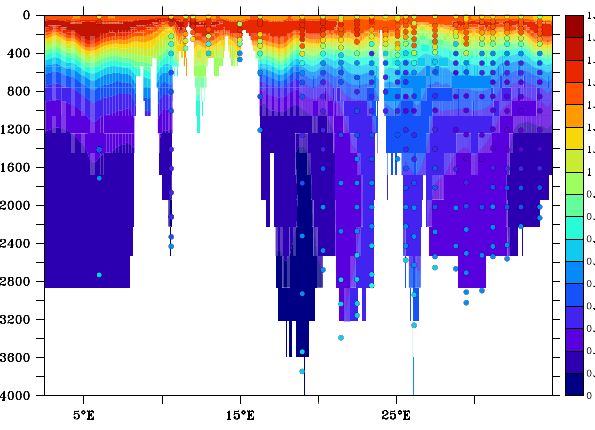
Figure 4. CFC-12 (pmolkg − 1 ) data–model comparison along the Meteor M51/2 section. Color-filled contours indicate simulated CFC-12, whereas color-filled dots show in situ observations. Both use the same color scale and are taken at the same time (Novem- ber